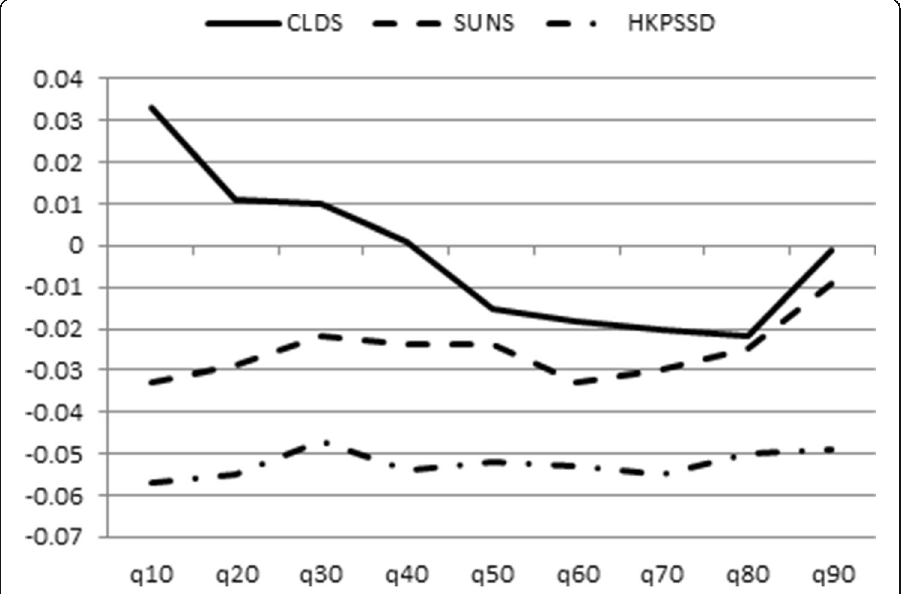
Fig. 4 Differentials in return on education between precarious workers and non-precarious workers (quantile